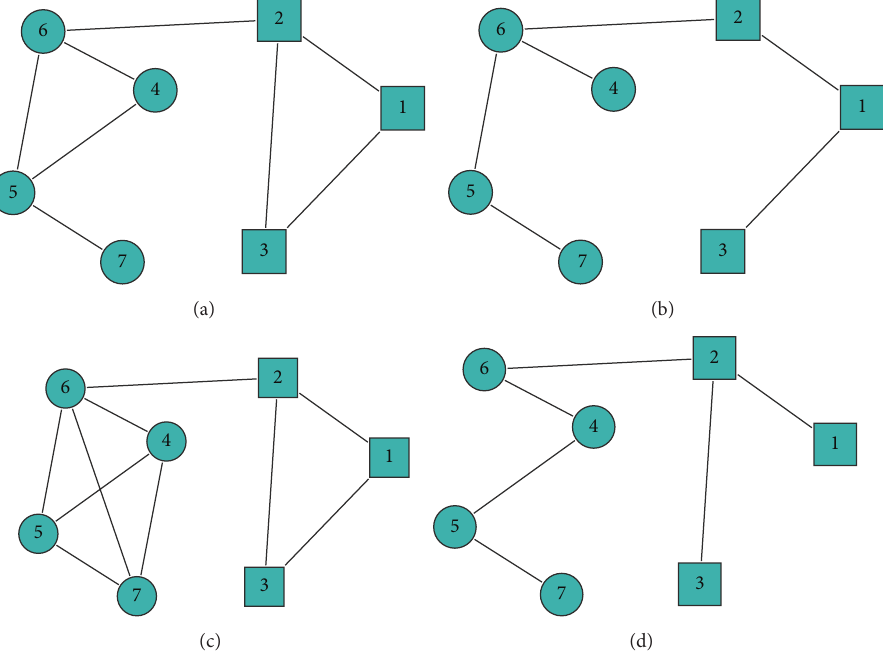
Figure 1: The topology structures of the switching networks that have 7 nodes divided into 2 clusters (nodes {1,2, 3} and nodes {4,5,6,7} ). (a) and (c) show the topology structures of the coupling matrices 𝐴(1) and 𝐴(2) , respectively; (b) and (d) express the topology structures of the coupling matrices 𝐵(1) and 𝐵(2) , respectively.